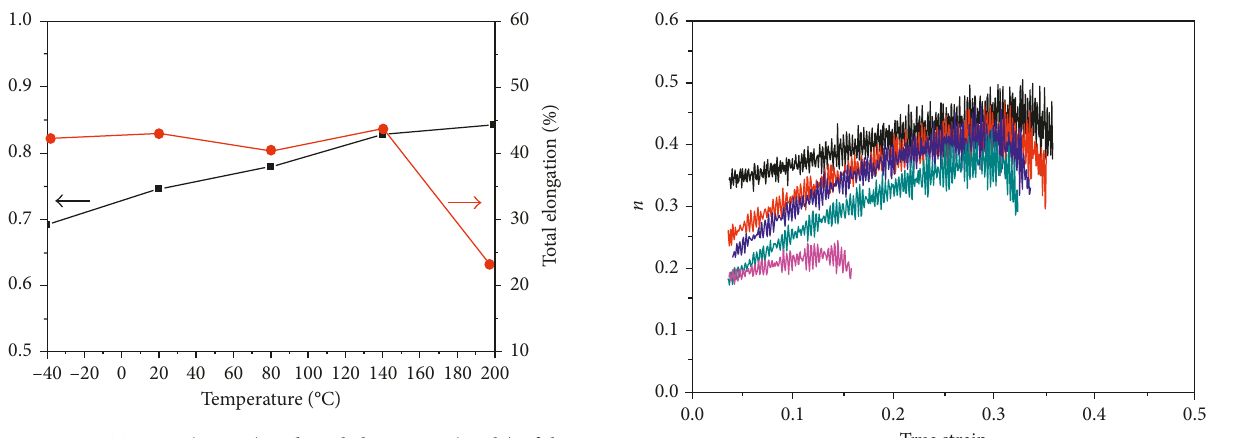
Figure 5: YS/UTS ratio (square) and total elongation (circle) of the X6MnSiAlNbTi26-3-3 steel at various tensile test